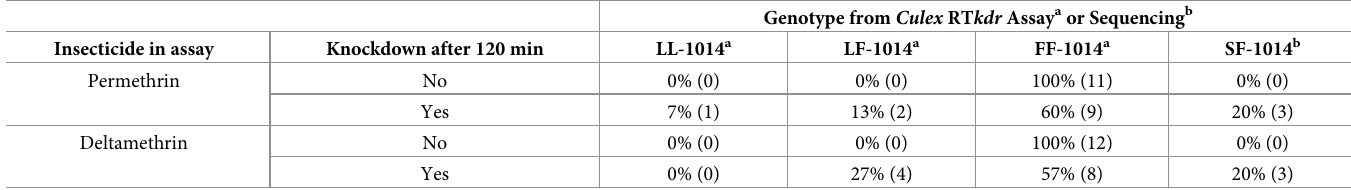
Table 2. Genotype of the Conaway strain mosquitoes from the bottle bioassays. Percentage values are for each knockdown state (No or Yes) in the bottle bioassay, number of mosquitoes are in parenthesis and superscripts indicate if the genotype was determined with the Culex RT kdr Assay and confirmed with Sanger sequencing a , or only Sanger sequencing b